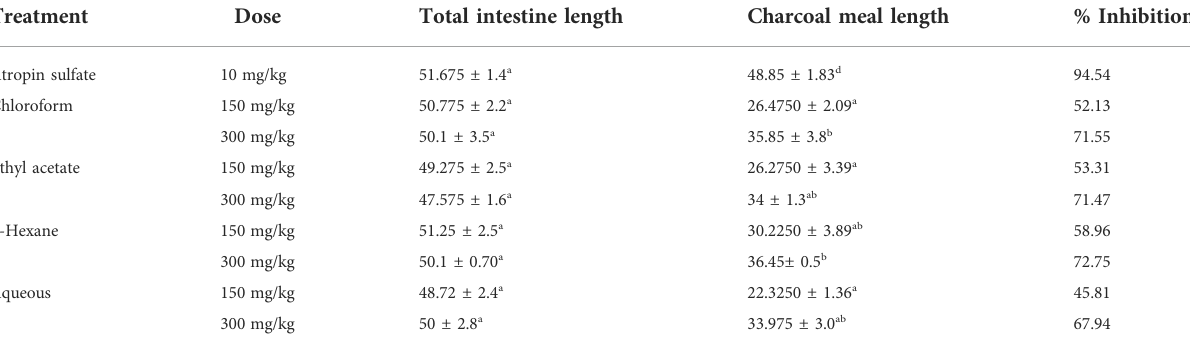
TABLE 2 Effect of different fractions of Justicia adhatoda on intestinal transit in